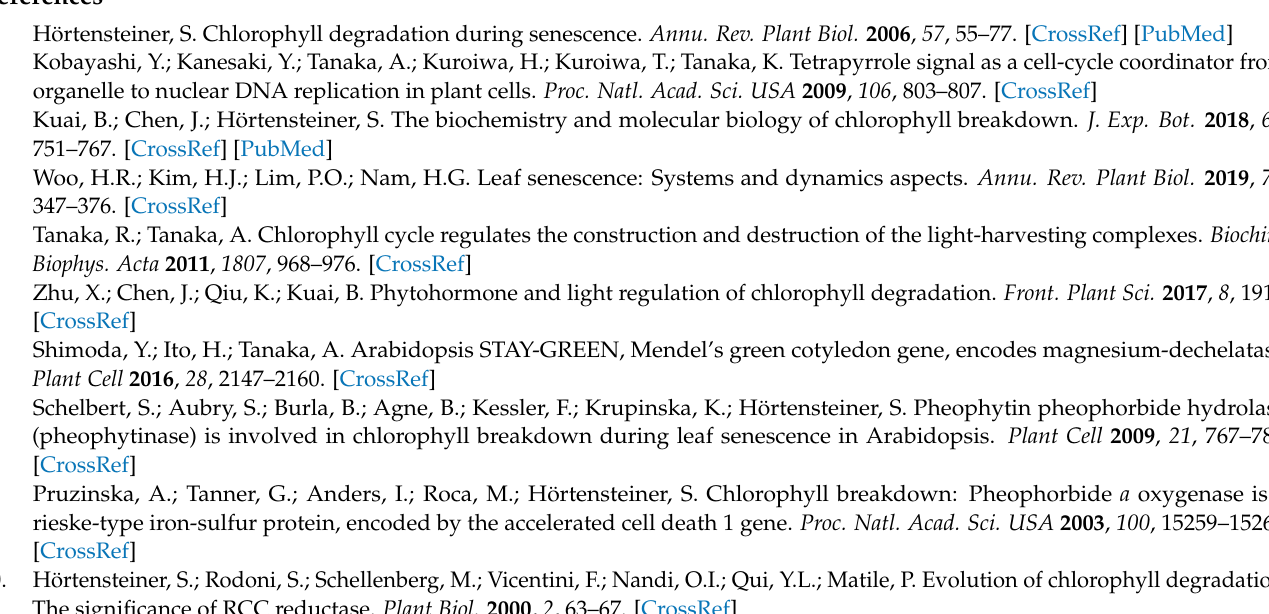
species. Figure S2: Identification of the CsHCAR overexpression transgenic tobacco plants. Table S1: GenBank accession numbers of HCAR used to build phylogenetic tree. Table S2: Primers used for qPCR assays. Table S3: Primer sequences for vector